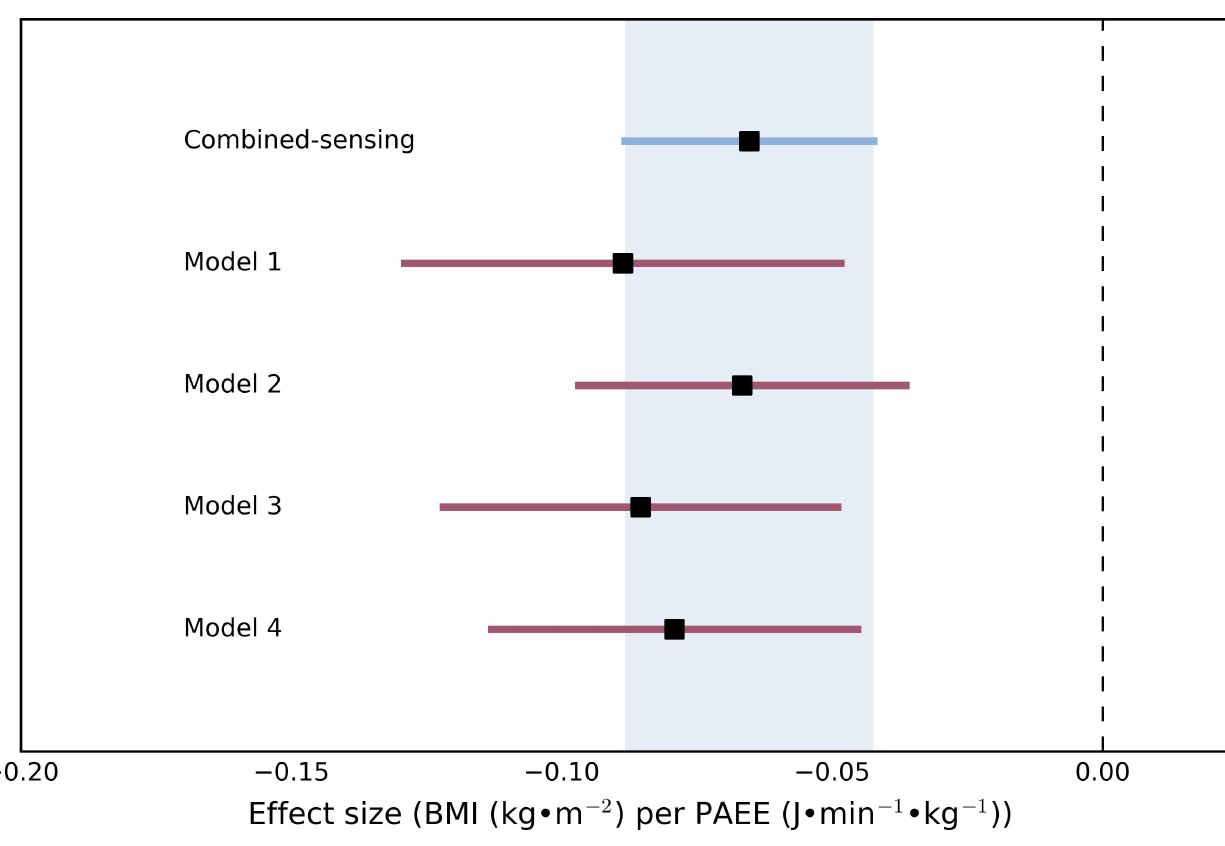
Fig 4. Forest plot showing the beta point estimatesand their respective confidence intervals of the effect size of PAEE on